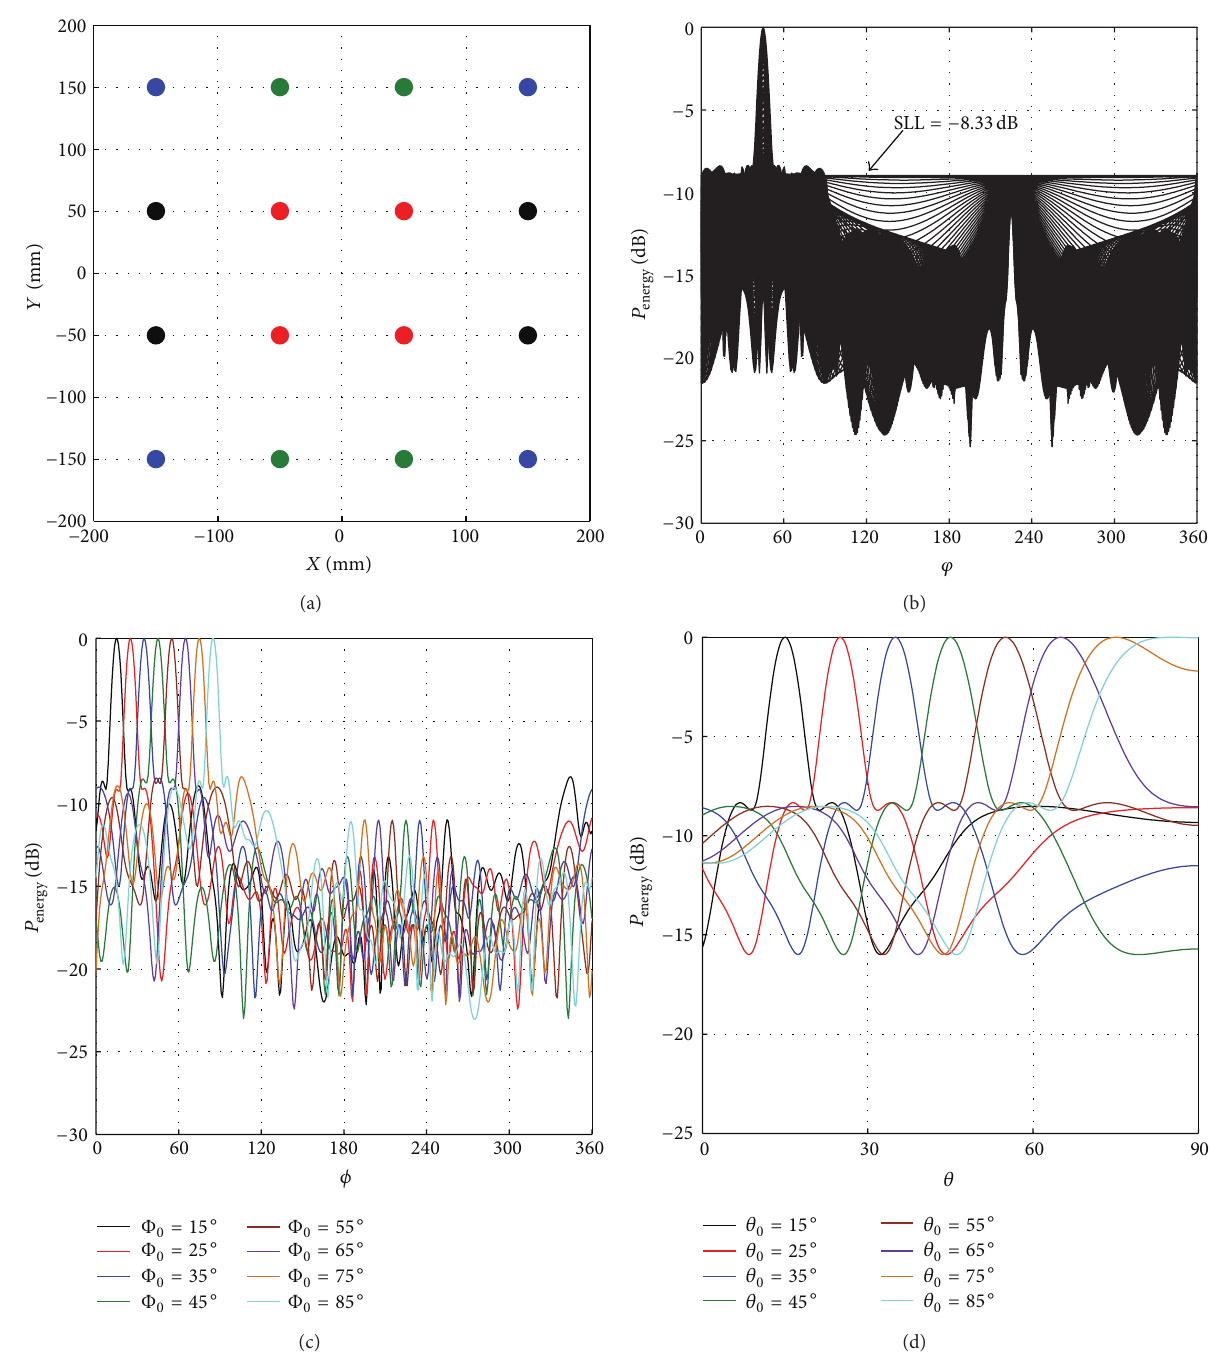
Figure 2: Result of USA: (a) antenna and delay distributions, (b) SEP in 𝜃 0 = 𝜑 0 = 45 ∘ , (c) azimuth cuts with 𝜃 0 = 45 ∘ , and (d) elevation cuts with 𝜑 0 = 45 ∘